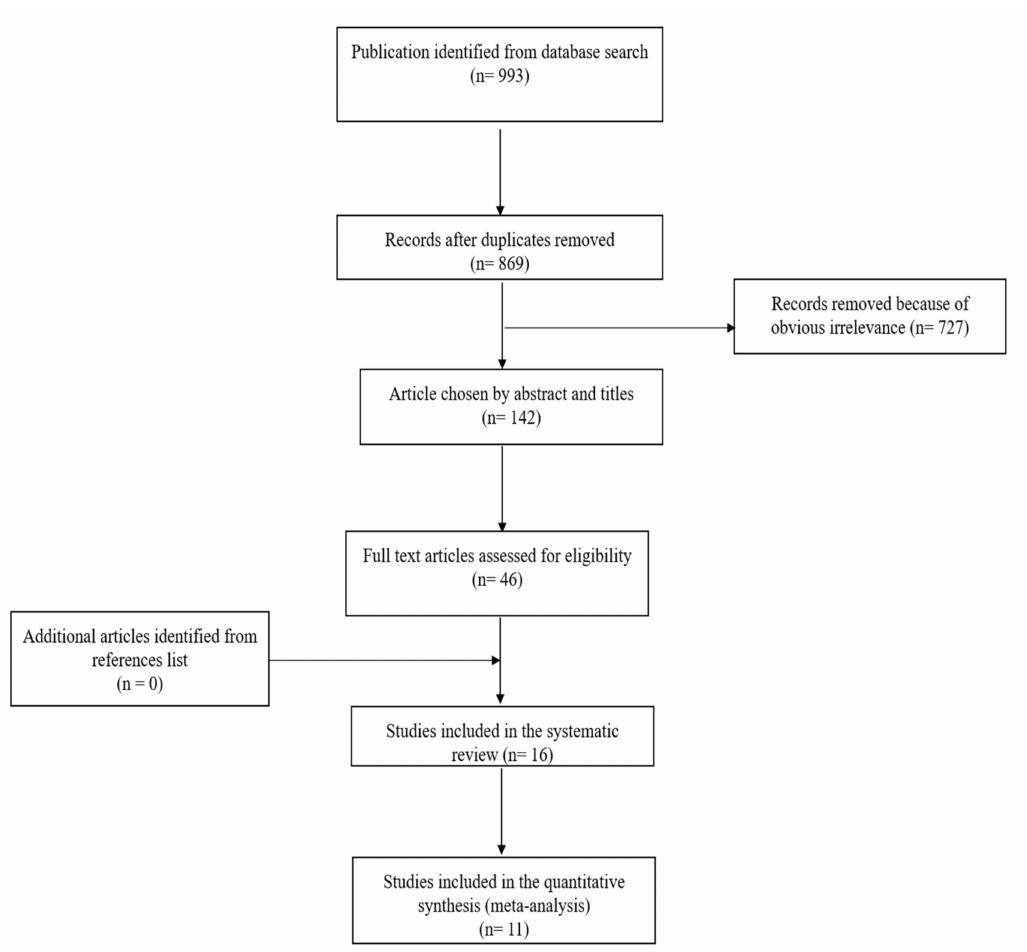
Figure 2. PRISMA (Preferred Reporting Items for Systematic Reviews and Meta-Analysis) flow chart of studies included in systematic review and